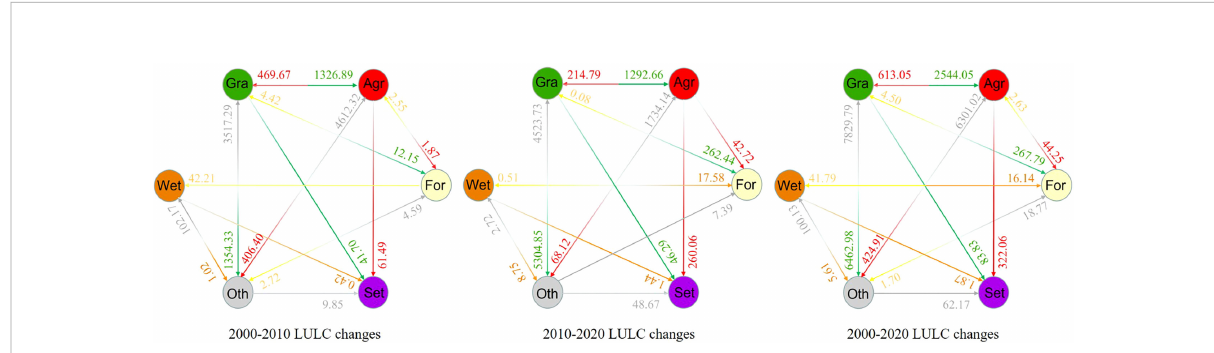
FIGURE 3 Transfer matrix of each LULC class for 2000-2010, 2010-2020, and 2000-2020. Gra, Agr, For, Set, and Wet refer to grassland, agricultural land, forestland, settlement, and wetland respectively. Whereas Oth refers to other type of LULC which include water, bare land, snow and ice. Different colors represent different LULC types, arrows represent the direction of LULC type transfer, and corresponding numbers represent the area of LULC